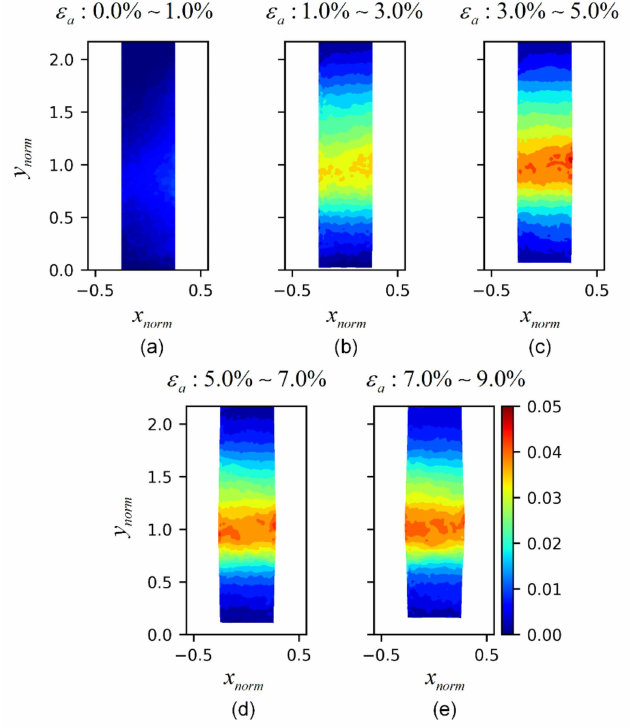
Figure 23. Evolution of gradient along ˆ ρ axis F 11 of test 121304b: ( a ) axial strain 0.0%–1.0%; ( b ) axial strain 1.0%–3.0%;( c ) axial strain 3.0%–5.0%;( d ) axial strain 5.0%–7.0%;( e ) axial strain